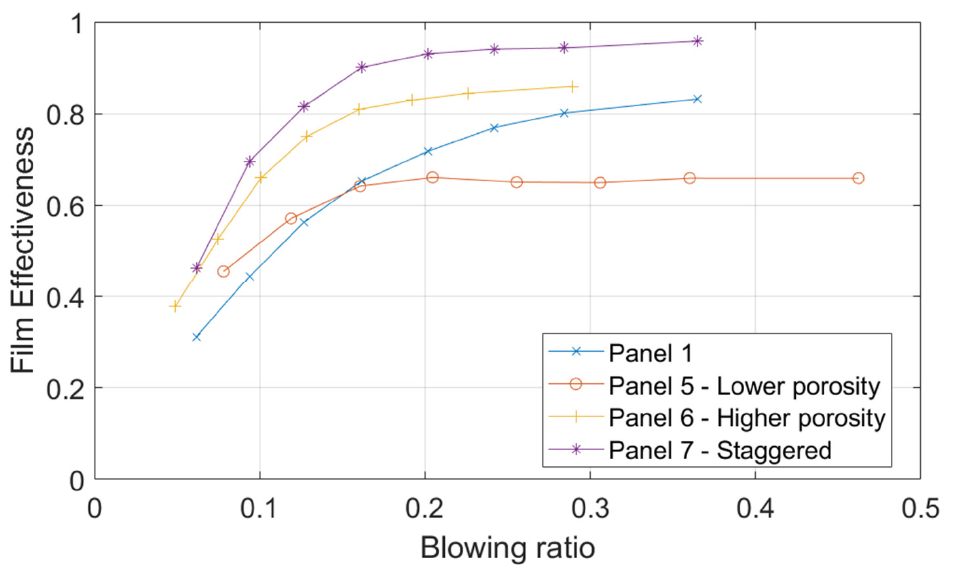
Figure 10. Film effectiveness of Panels 1, 5, 6 and 7 at x/d = 75 at different average blowing ratios.